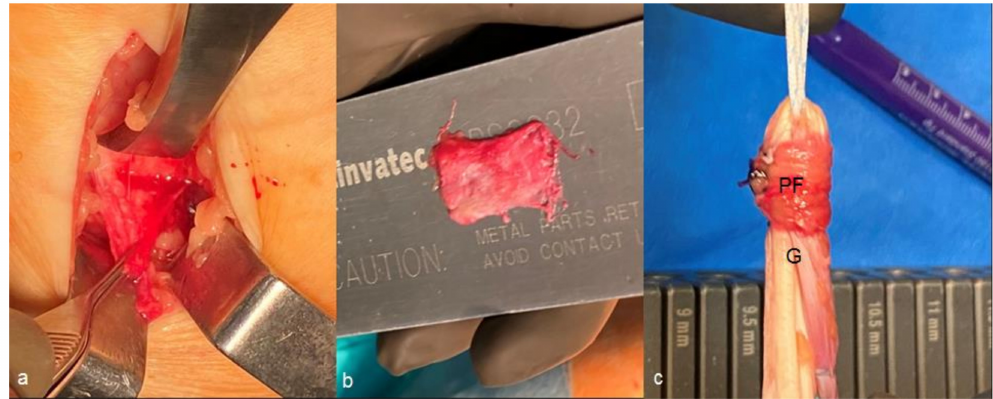
Figure 3. Preparation of a periosteal flap to enhance the femoral part of a graft: ( a ) Harvesting of the periosteum below the pes anserinus attachment; ( b ) Free periosteal flap; ( c ) Femoral part of an anterior cruciate ligament graft (G) augmented with a free periosteal flap